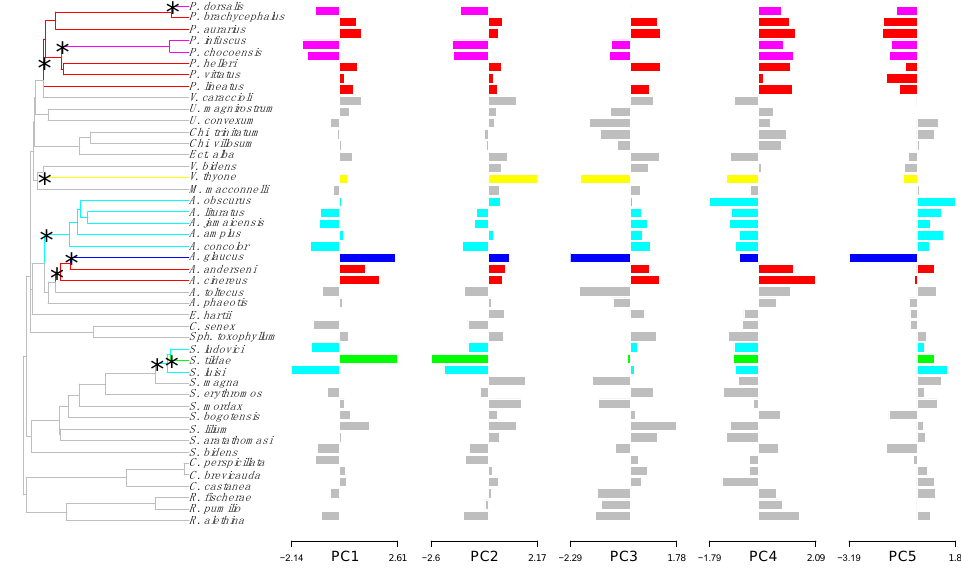
Figure 2. Shifts in adaptive peaks for skull morphology of Neotropical frugivorous bats. Shifts in adaptive peaks are indicated with asterisks and convergent shifts in adaptive peaks have the same branch color.